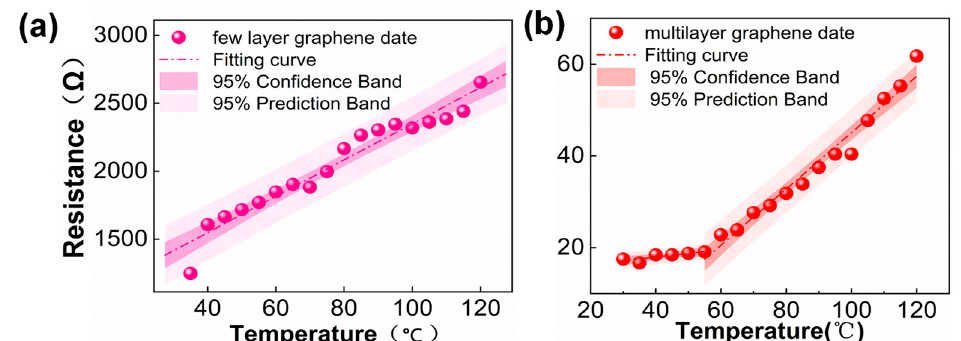
Figure 5. Sensitivity fitting curves for few-layer and multilayer graphene cavity structures. The sensitivity equation S = ( ∆ R/R)/ ∆ T shows that the sensitivity of the few-layer graphene cavity is 1.07%/°C and the sensitivity of the multilayer graphene cavity is 3.50%/°C. ( a ) is the sensitivity of few-layer graphene. ( b ) is the sensitivity of multilayer graphene. Table 1. Graphene temperature sensors in di ff erent works.